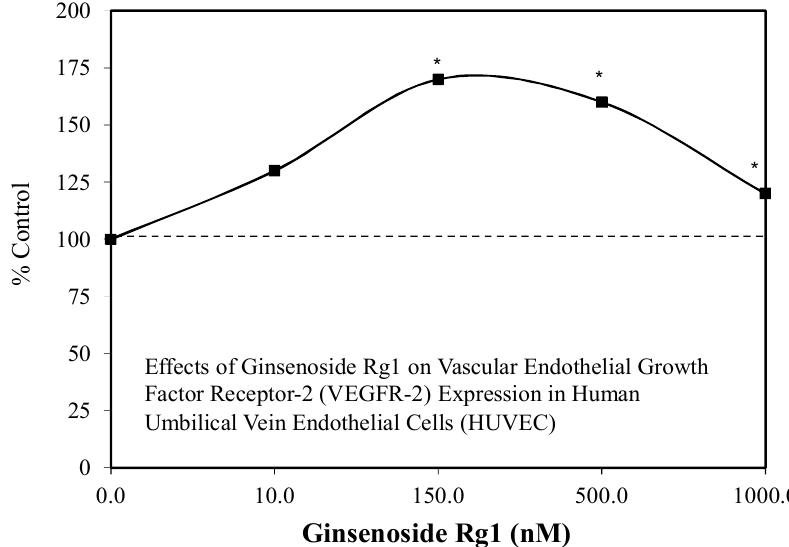
Figure 10. Effects of ginsenoside Rg1 on vascular endothelial growth factor receptor-2 (VEGFR-2) expression in human umbilical vein endothelial cells (HUVEC) (Source: [56]). Each * represent statistical significance for a data point.